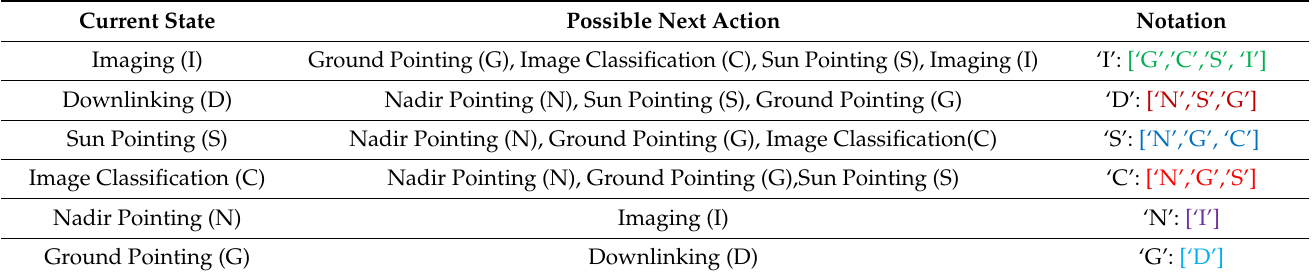
Table 5. Action Set of